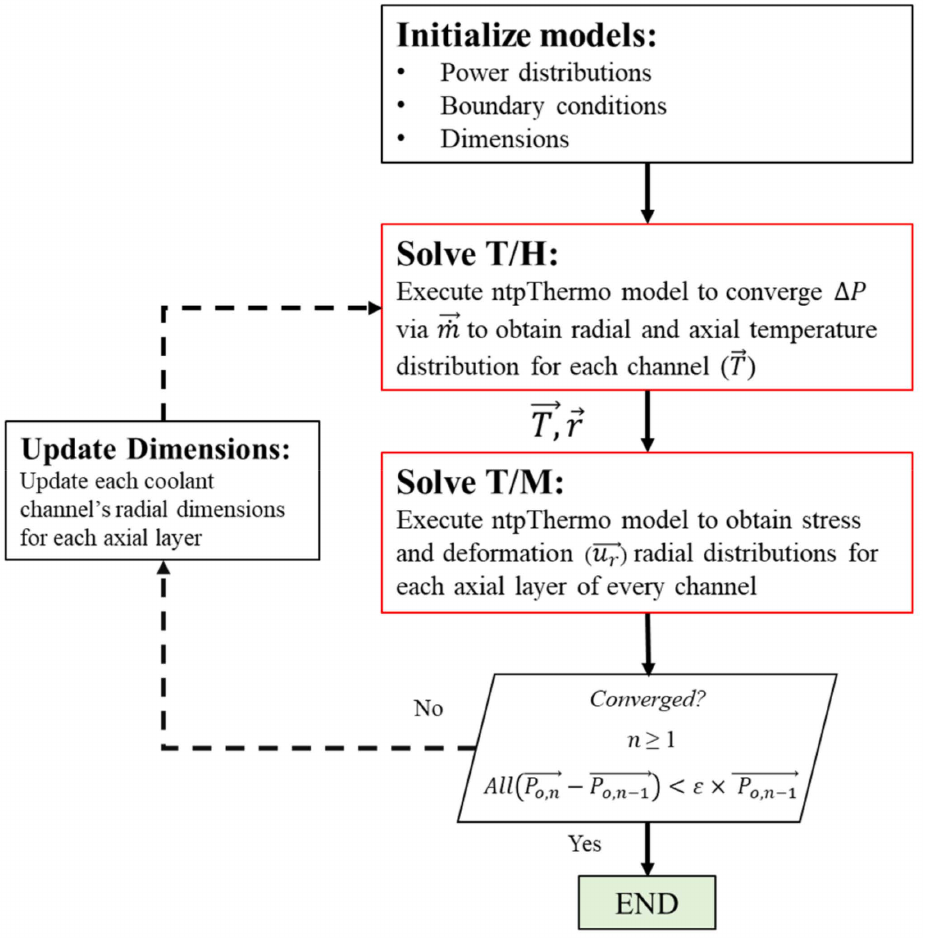
Figure 1. Coupled T/H–T/M solution